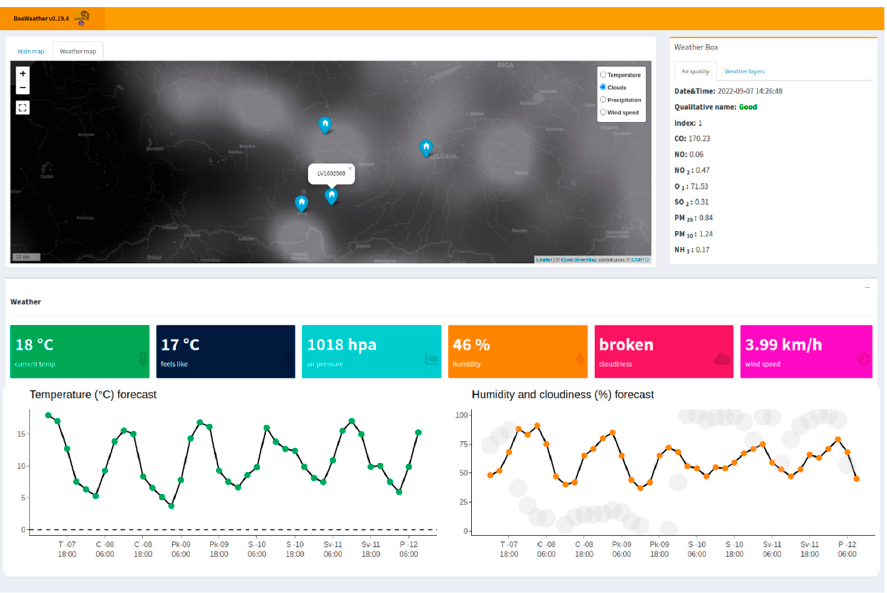
Figure 8. Weather module of the interactive map